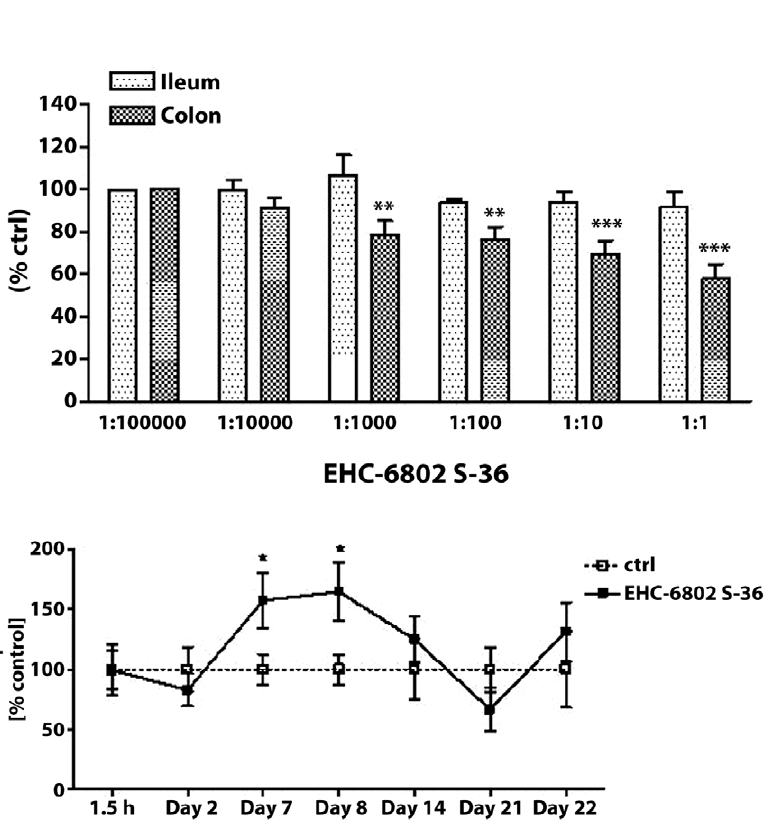
Figure 2. The effect of EHC-6802 on mouse GI motility. A) The effect of EHC-6802 (initial concentration 360 m g/200 m l regarded as 1:1 dilution) on EFS (8 Hz)-stimulated smooth muscle contractions in mouse ileum and colon. Note that EHC-6802 significantly, in a concentration-dependent manner inhibited twitch contractions in mouse colon. Data represent mean 6 SEM for n=8. *P , 0.05, as compared with control. B) In vivo effects of EHC-6802 (360 m g/200 m l/animal, QD, p.o.) on colonic bead expulsion time in mice. The results are shown as mean 6 SEM of n=5–10 mice for each experimental group. *P , 0.05, as compared with control (animals receiving tap water).